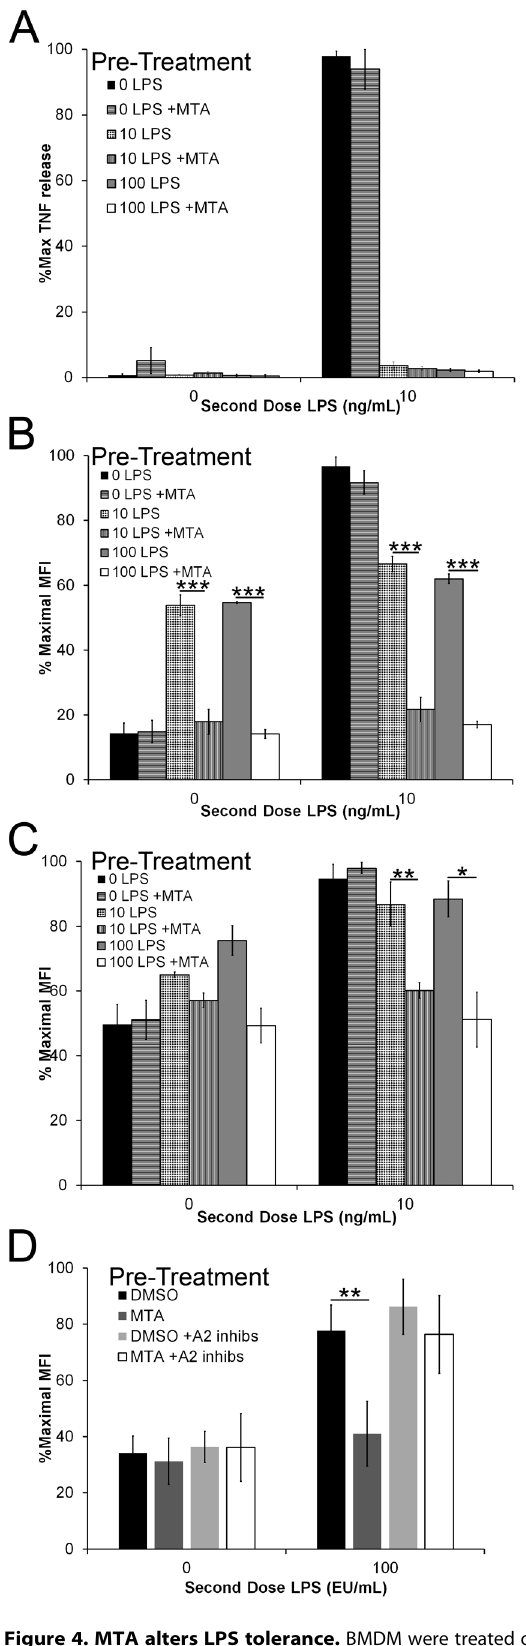
Figure 4. MTA alters LPS tolerance. BMDM were treated overnight with either 0 ng/mL, 10 ng/mL, or 100 ng/mL (A–C) or 100 EU/mL